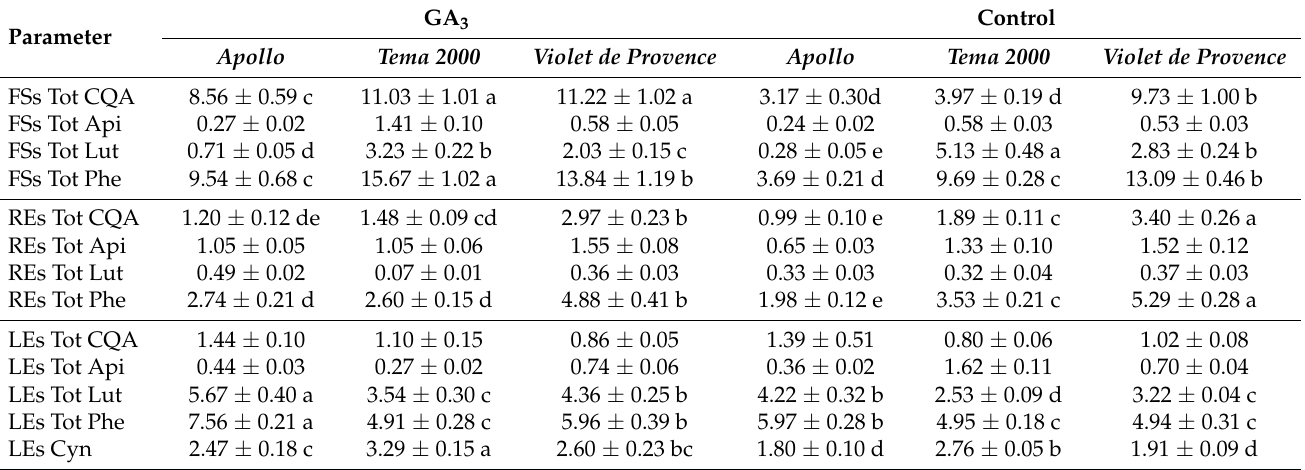
Table 3. Content (g kg − 1 of D.M.) of total caffeoylquinic acid (Tot CQA), total apigenin (Tot Api), total luteolin (Tot Lut), total polyphenol (Tot Phe), and cynaropicrin (Cyn) in the floral stems (FSs), recep- tacles (REs), and leaves (LEs) of the globe artichokes as affected by the ‘GA 3 treatment × genotype’ interaction. Different letters within the same row show significant differences among means ± s.d. (LSD test, p < 0.05).